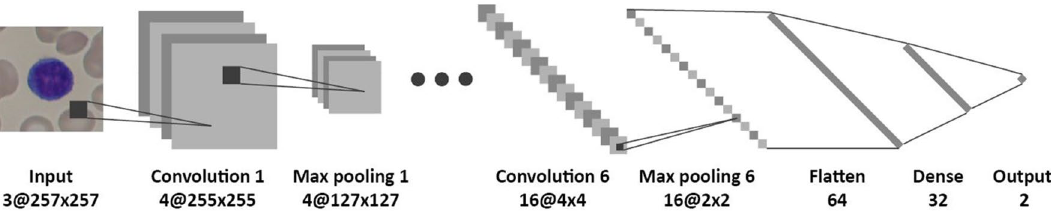
Figure 2. Network structure of the model used for binary classification. The network consists of six pairs of convolutional layers (with kernel size 3 × 3) and max-pooling layers. The feature maps are flattened and reduced to an output of size two. In total the network contains 7210